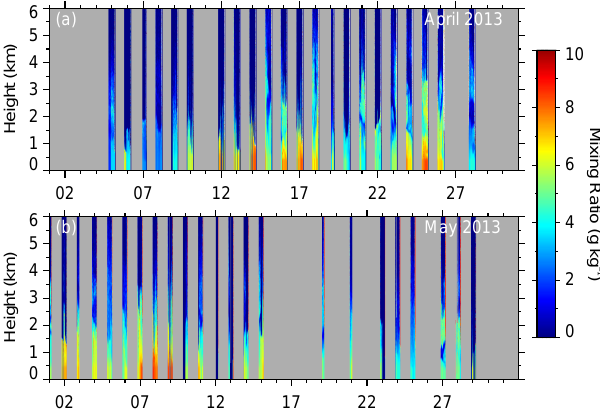
Figure 6. Overview over the water vapour profiles observed by Polly XT during HOPE: (a) April and (b) May 2013.